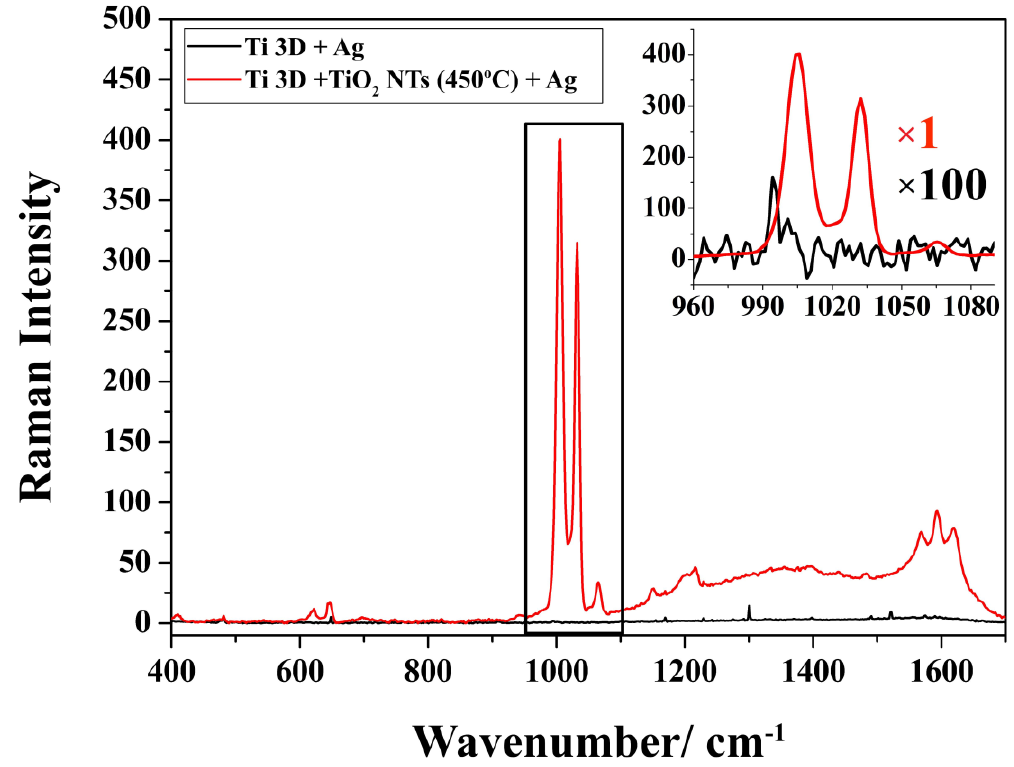
Figure 9. SERS spectra of adsorbed pyridine (0.05 M + 0.1 M KCl) on the surface of samples Ti 3D + TiO 2 NTs (450 °C) + 0.02 mg/cm 2 and Ti 3D + 0.02 mg/cm 2 . TiO 2 NTs (450 ◦ C) + 0.02 mg/cm 2 and Ti 3D + 0.02 mg/cm 2